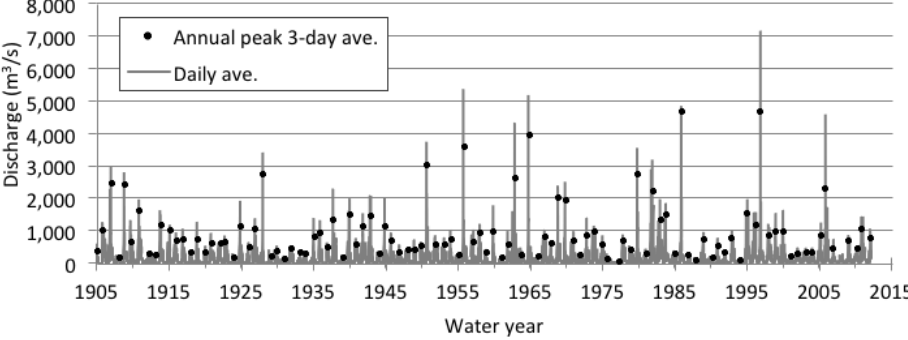
Figure 2. Daily hydrograph at Fair Oaks USGS gauge on the American River, CA.